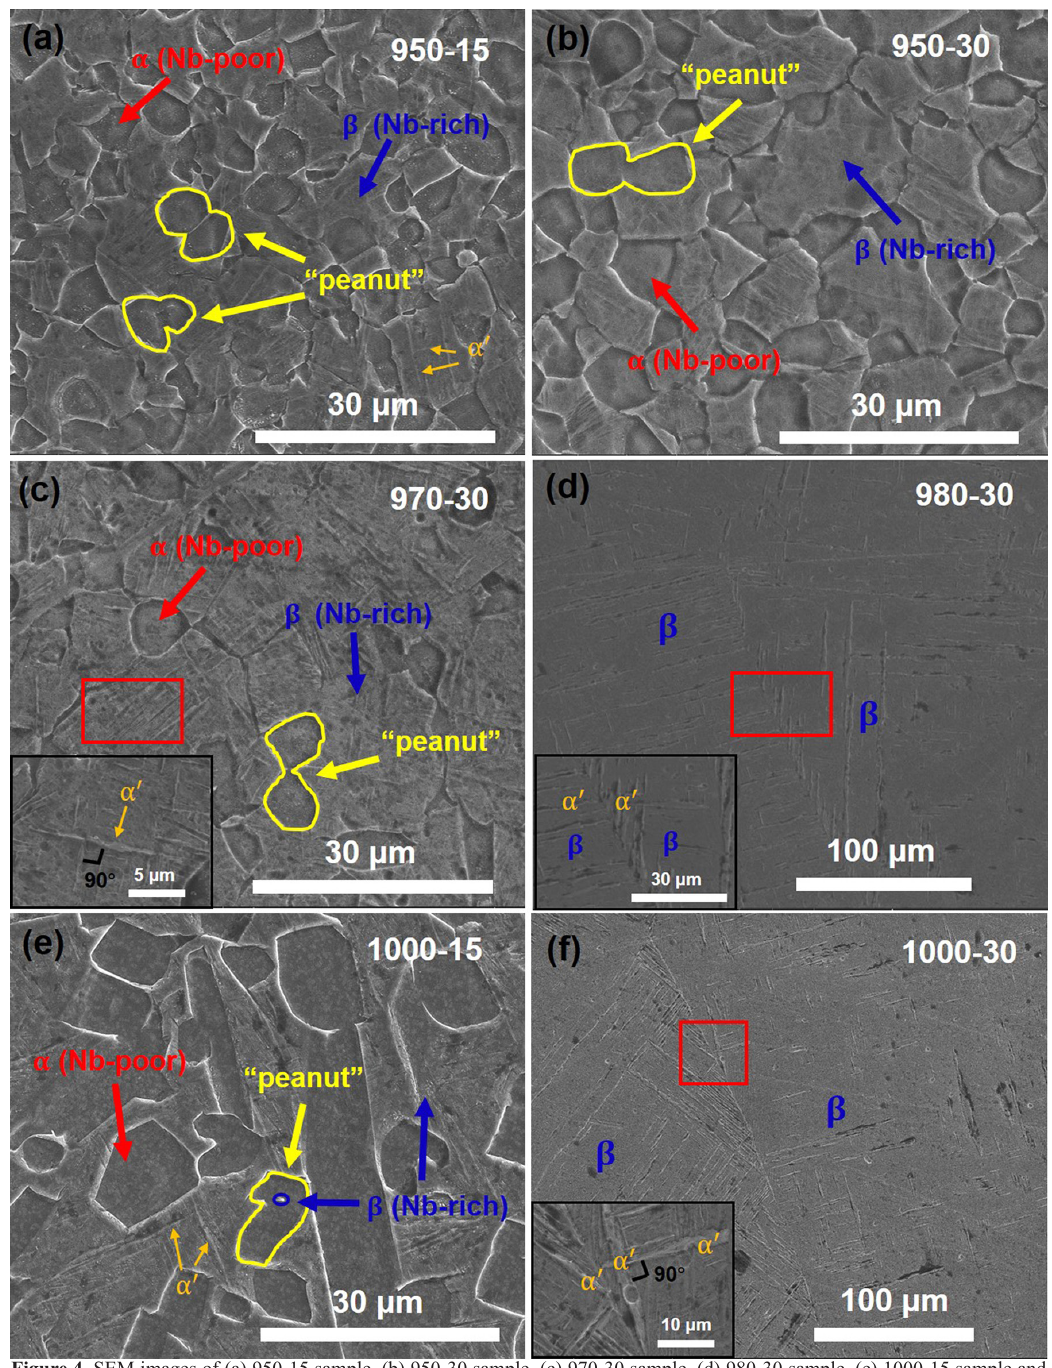
Figure 4. SEM images of (a) 950-15 sample, (b) 950-30 sample, (c) 970-30 sample, (d) 980-30 sample, (e) 1000-15 sample and (f) 1000-30 sample. Table 3. The EDS results of α´ phase with different annealing The microstructure in Figure 4e shows that 1000-15 sample temperatures and time. consists of β phase, α phase and acicular α' phases. In addition, Elements parts of the α grains are contiguous with a “peanut” shape, as is Heat treatment condition observed in Figure 4a to 4c. The size of grains in the 1000-15 sample is the largest among all specimens and reaches a value of about 15 μm. Figure 4f shows the microstructure of 1000-30